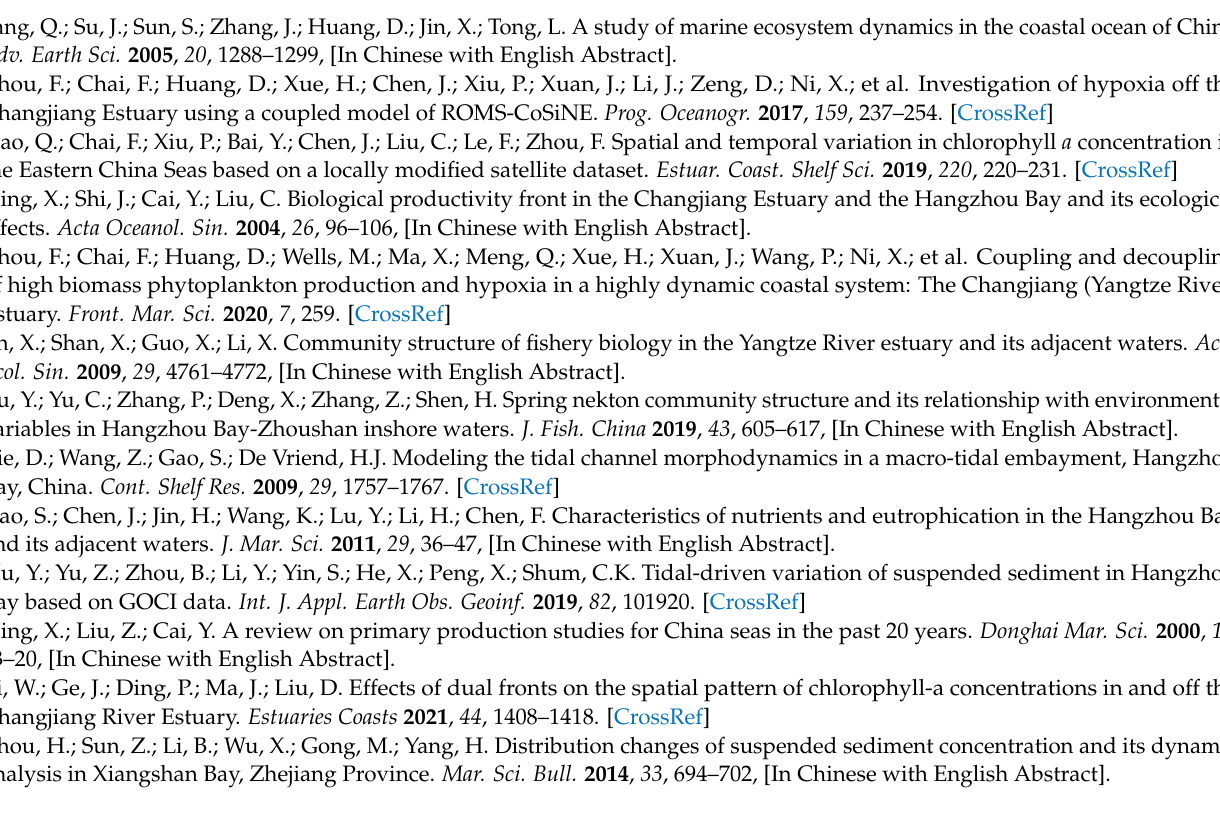
Figure A2. Seasonal variations of ( A ) the mean Chl in the mixed layer (mg · m − 3 ), ( B ) surface PP (mg C · m − 3 · h − 1 ), ( C ) surface P B (mg C · (mg Chl · h) − 1 ), ( D ) the mean DIN in the mixed layer ( µ mol · dm − 3 ), ( E ) the mean DIP in the mixed layer ( µ mol · dm − 3 ) and ( F ) the mean DSi in the mixed layer ( µ mol · dm − 3 ).